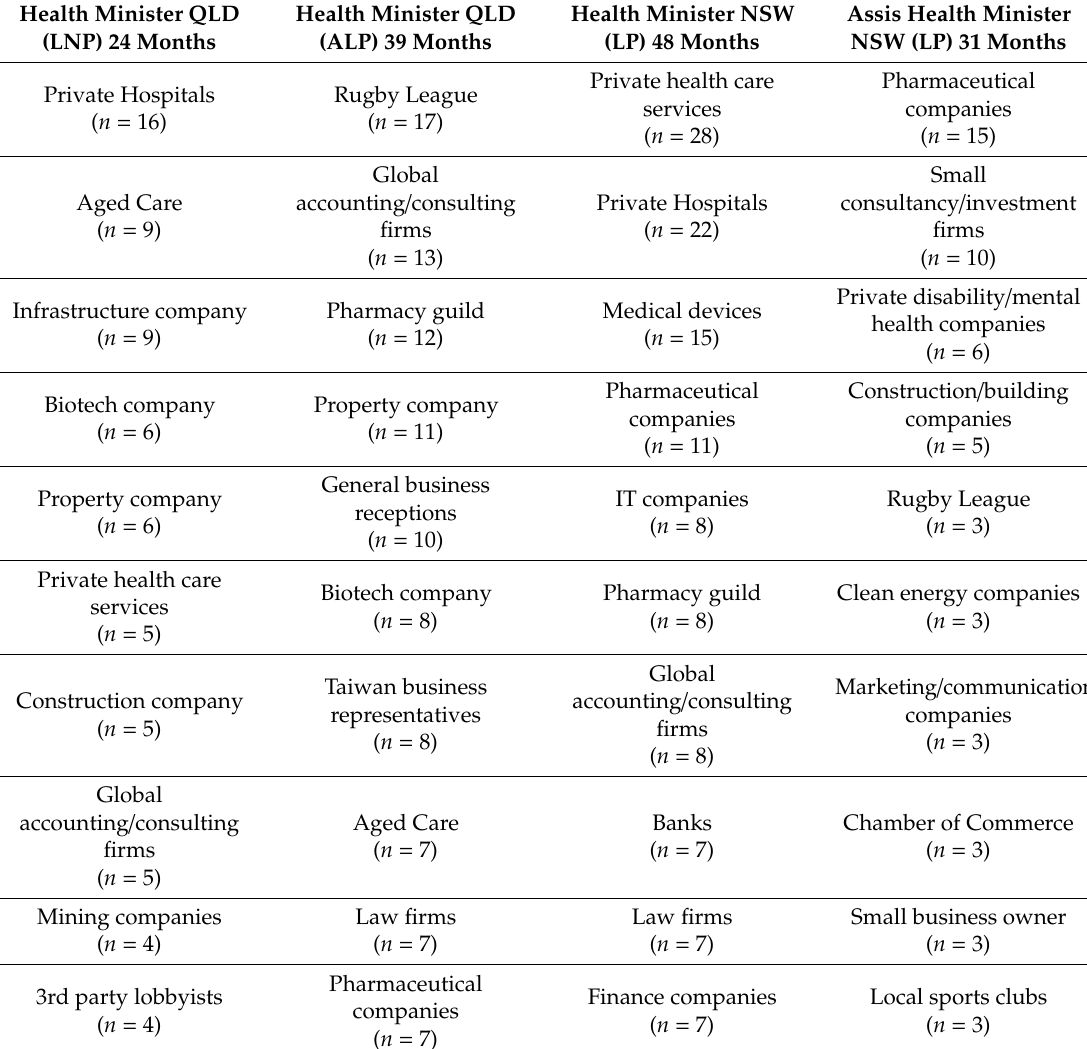
Table 4. Top recorded business interactions in health ministers’ diaries (January 2013–June 2018)